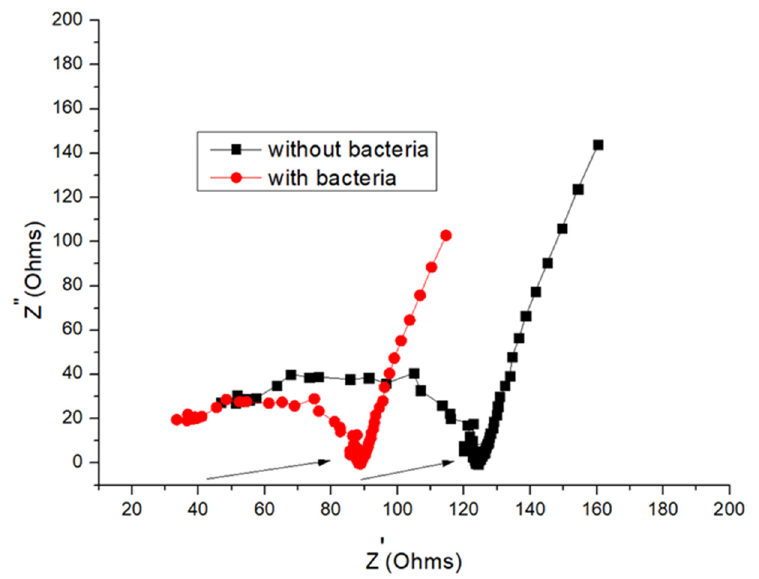
Figure 6. Shows the internal resistance of the MFC with and without bacteria.